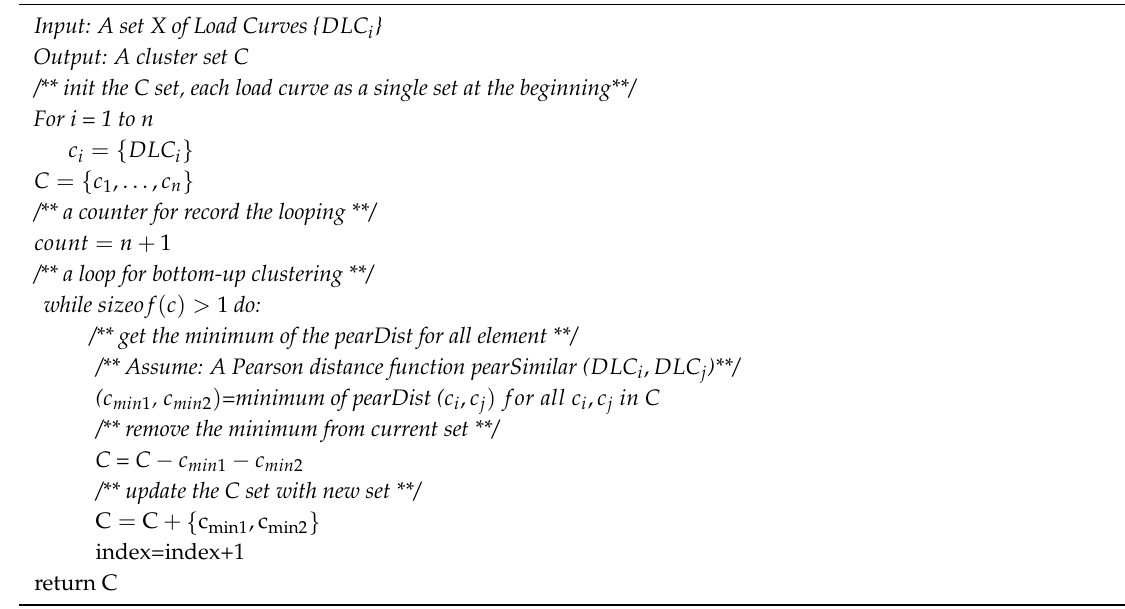
Algorithm 2. The Weight Pearson based Hierarchy Clustering Algorithm.